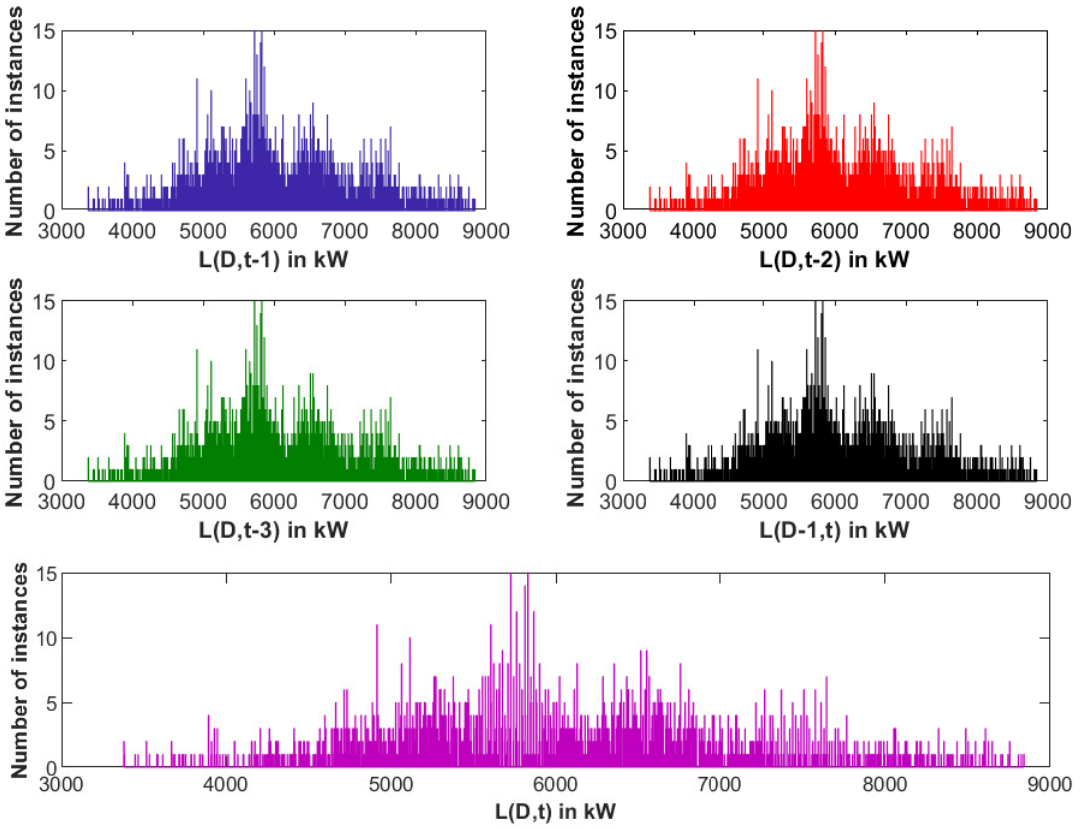
Figure 15. MLR: Data observation using histogram